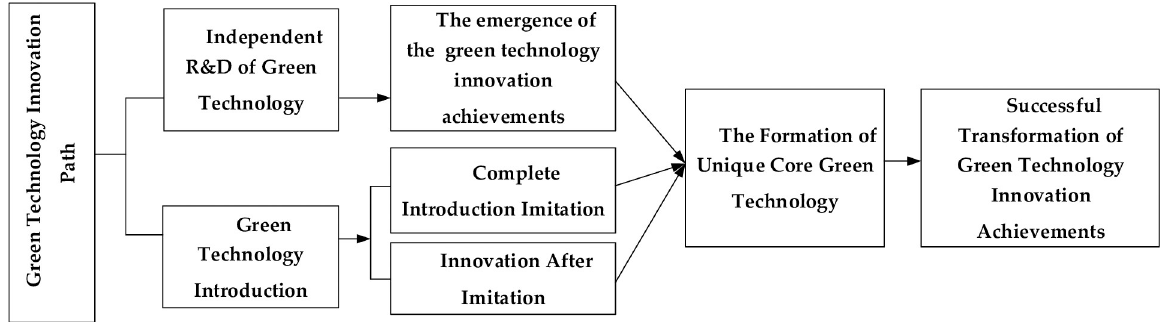
Fig 2. The division of green technology innovation